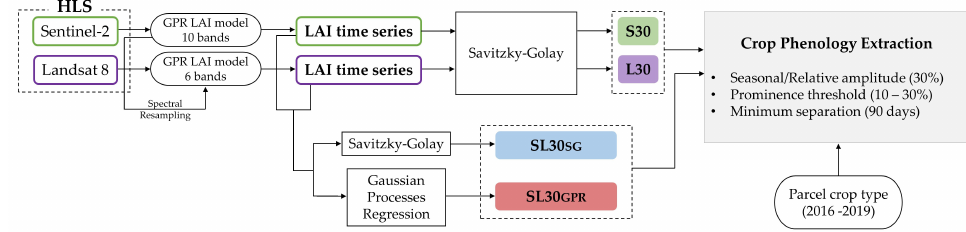
Figure 1. Workflow of the proposed methodology for cropland phenology extraction from HLS.